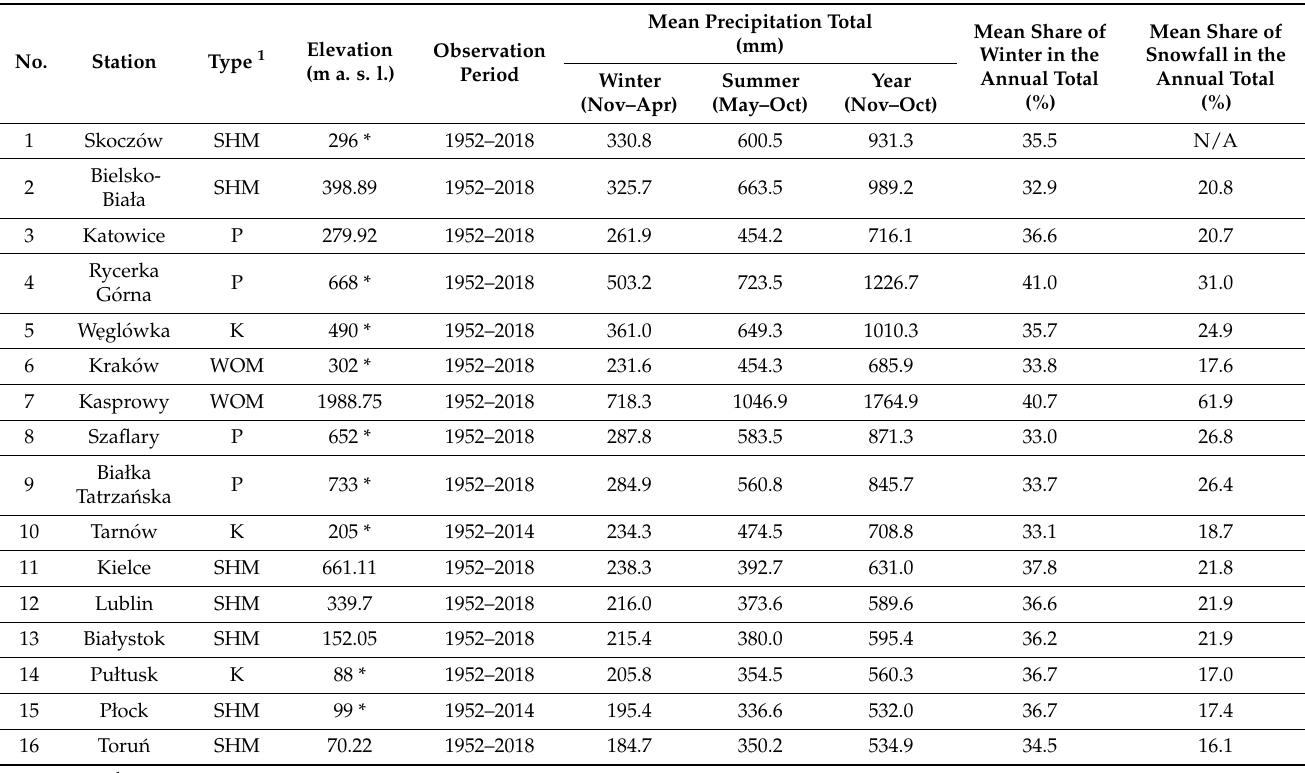
Table 1. List of the selected meteorological stations with essential information on mean seasonal and annual precipitation